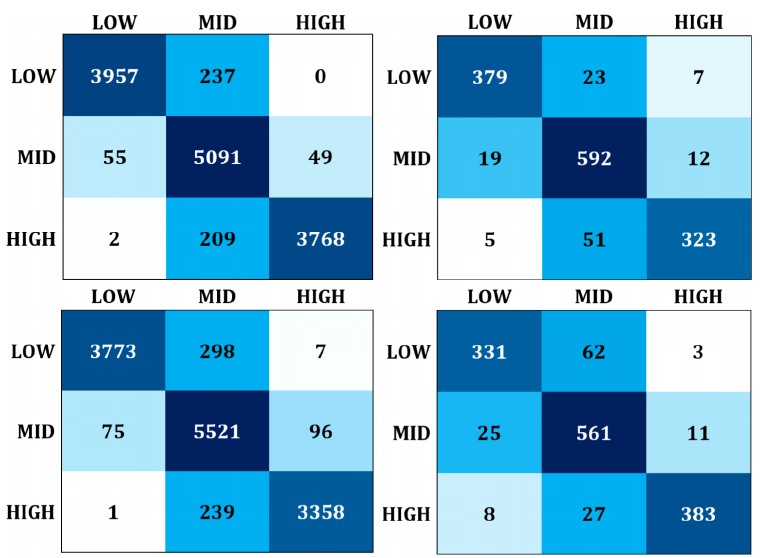
Figure 4. Confusion matrices: ( top-left ) train set with Arousal; ( top-right ) test set with Arousal; ( bottom-left ) train set with Valence; and ( bottom-right ) test set with